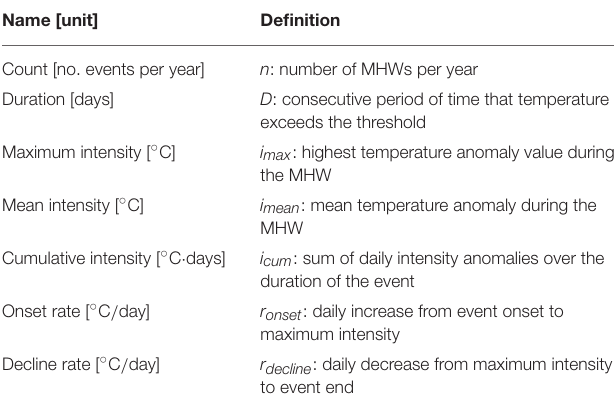
TABLE 1 | The descriptions for the metrics of MHWs as proposed by Hobday et al. (2016) and adapted from Schlegel et al.